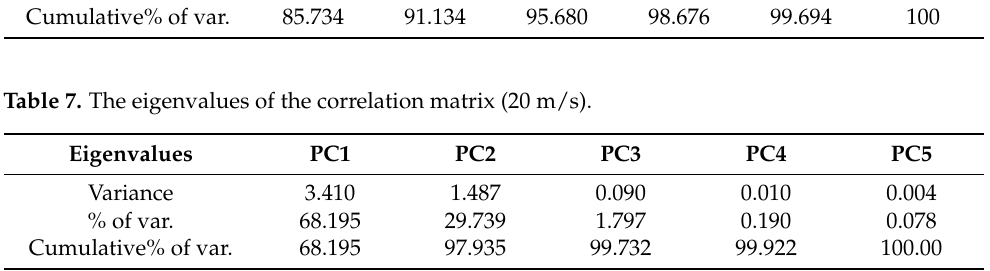
Table 6. The eigenvalues of the correlation matrix (15 m/s). Eigenvalues